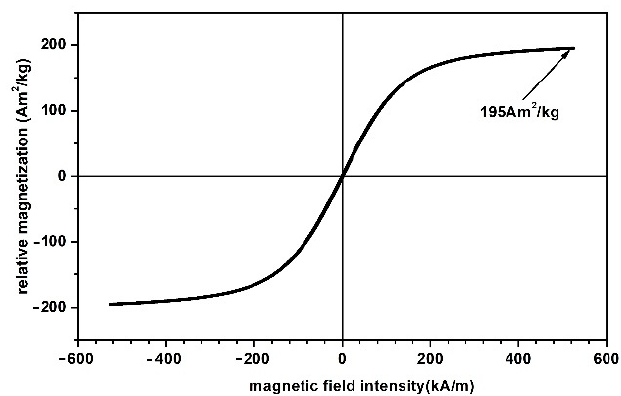
Figure 2. Magnetization slope for CIPs.